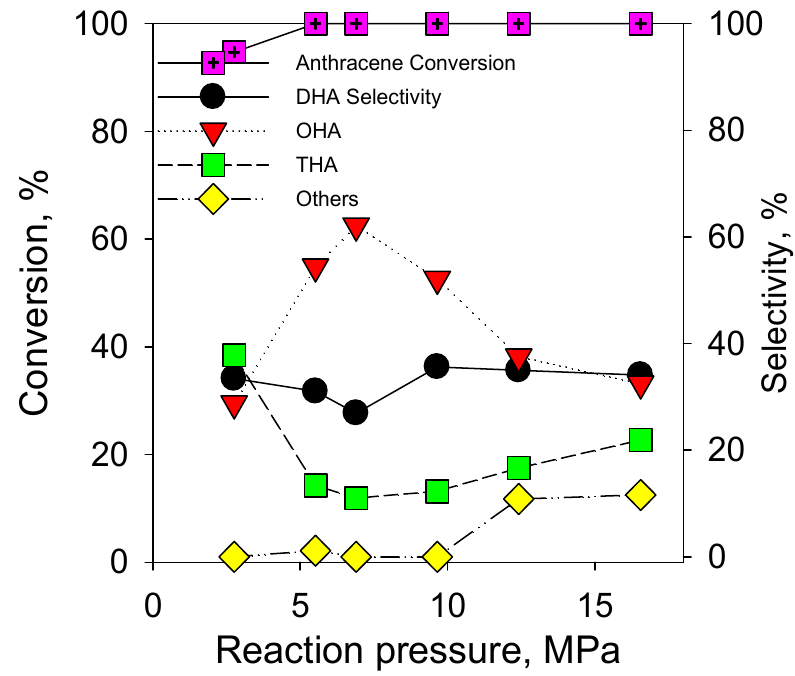
Figure 5. Effect of reaction pressure on hydrogenation of anthracene over 40% Ni/H β -zeolite catalyst. Catalyst weight: 0.5 g; Reaction temperature: 100 °C; H pressure: 2.76 MPa; volume of the reactor: 50 mL; reaction time: 6